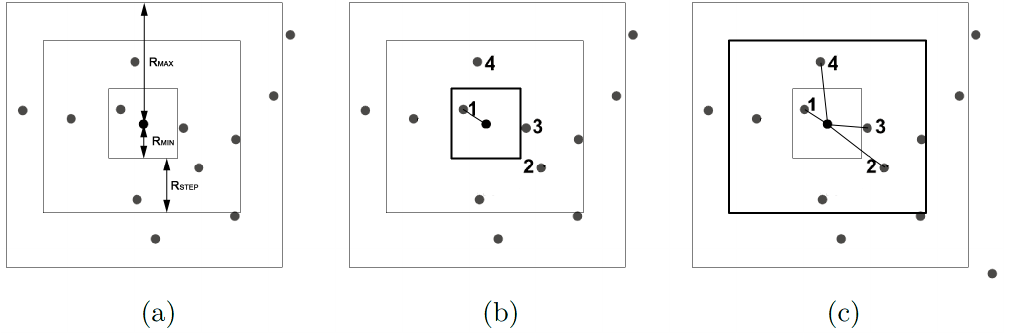
Figure 9. Behaviour of adaptive kriging algorithm. ( a ) Minimum search radius; ( b ) The number of points in search radius is too low; ( c ) The search radius is enlarged to contain a certain number of points. Simplified scheme of the proposed method is shown in Figure 10. Geosciences 2018 , 8 , x FOR PEER REVIEW 10 of 13